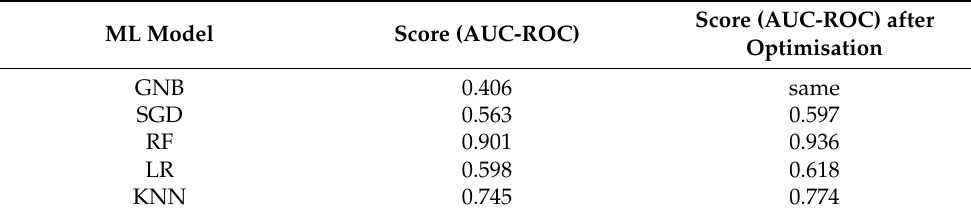
Table 5. Score Comparison of the Remaining ML Models using AHBO-TPE (Ember Dataset).